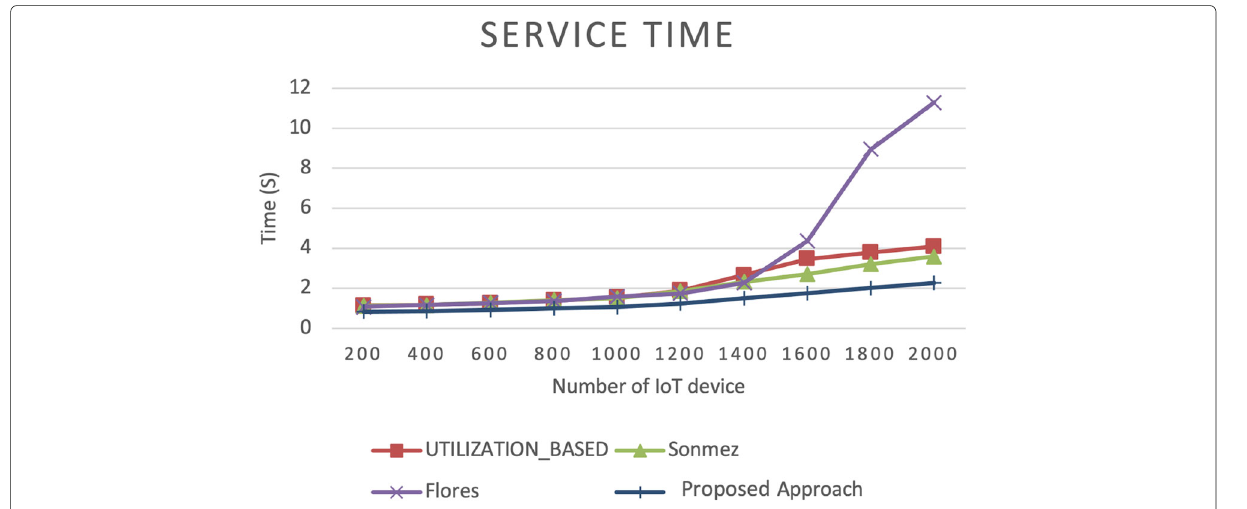
Fig. 8 The service time of the proposed approach with other related approaches